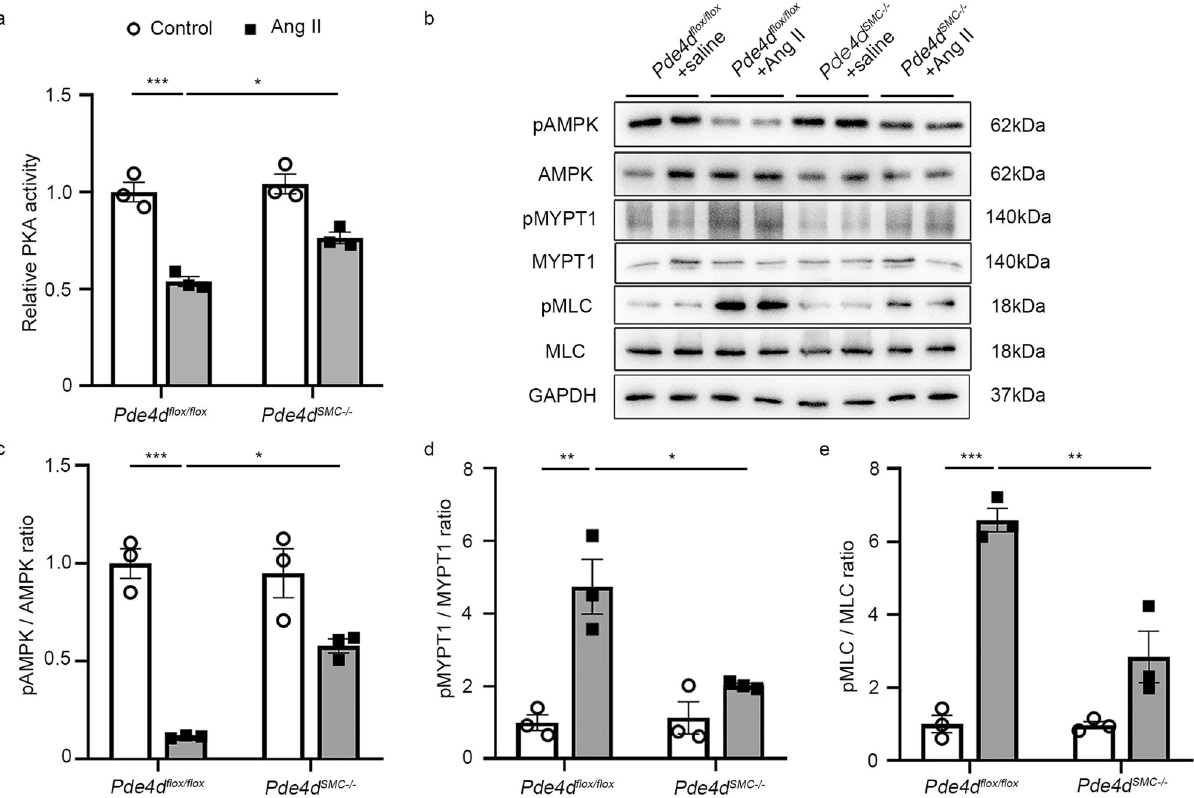
Fig. 5 PDE4D promotes vasocontraction through the PKA-AMPK-MYPT1-MLC signaling pathway in vivo. a PKA kinase activity in aorta tissues. b Representative western blot showing pAMPK, AMPK, pMYPT1, MYPT1, pMLC, and MLC expression in aorta tissues from Pde4d fl ox/ fl ox and Pde4d SMC − / − mice with or without Ang II treatment. c Quanti fi cation of pAMPK expression normalized to AMPK protein. d Quanti fi cation of pMYPT1 expression normalized to MYPT1 protein. e Quanti fi cation of pMLC expression normalized to MLC protein. n = 3 per group. Data are expressed as mean ± SEM. Two- way ANOVA with Bonferroni ’ s post hoc test was performed to compare the difference between the multiple groups. * p < 0.05, ** p < 0.01, and *** p <